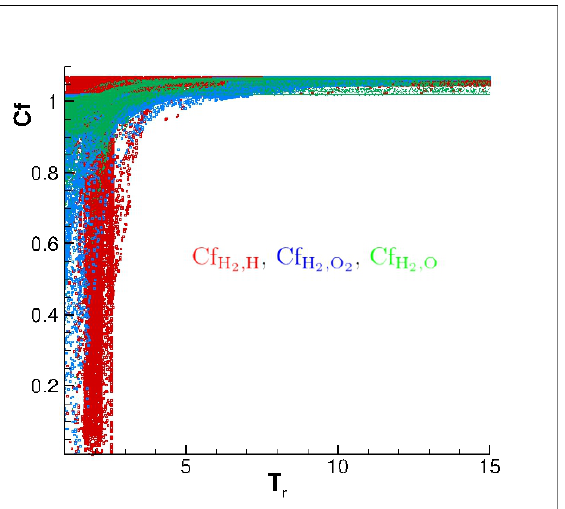
Figure 1. Takahashi’s correction factor versus mixture reduced temperature for some hydrogen binary diffusion coefficients evaluated from instantaneous flowfield of the H 2 /O 2 MASCOTTE combustion test case simulated in this